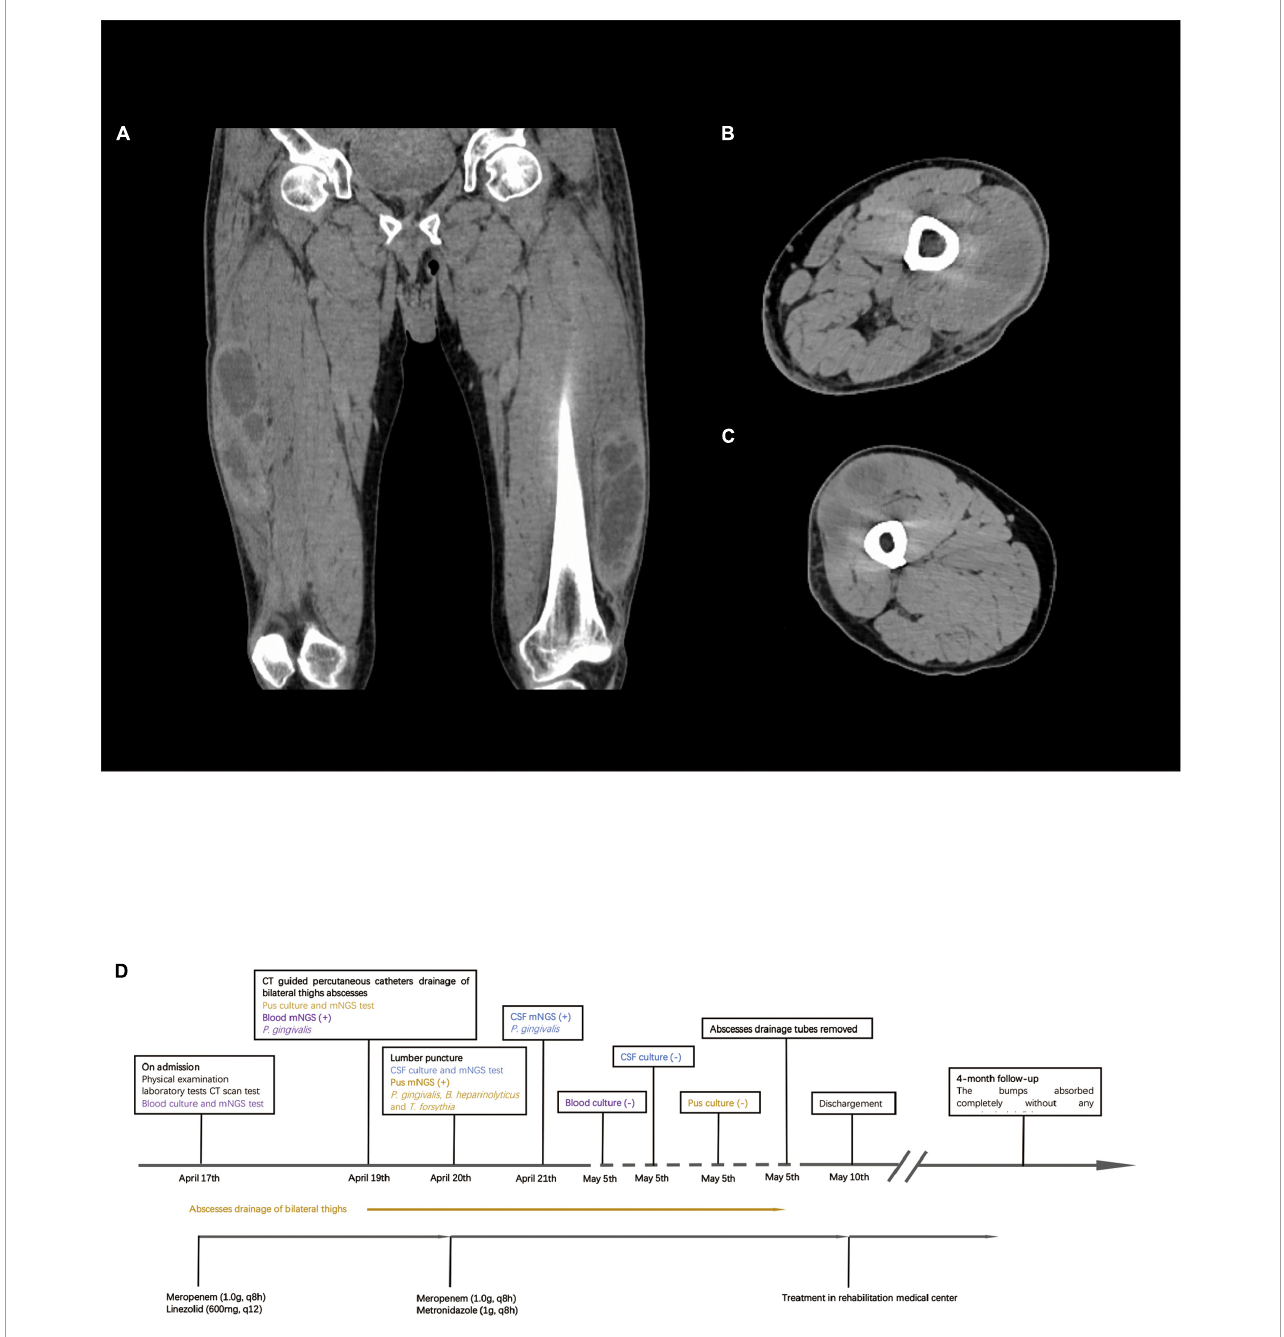
FIGURE2 Computed tomography (CT) scan result of bilateral lower extremities and timeline of treatment. (A) CT scan shows multiple muscle abscesses in bilateral thighs. (B) Right thigh abscess. (C) Left thigh abscess. (D) Timeline of treatment.